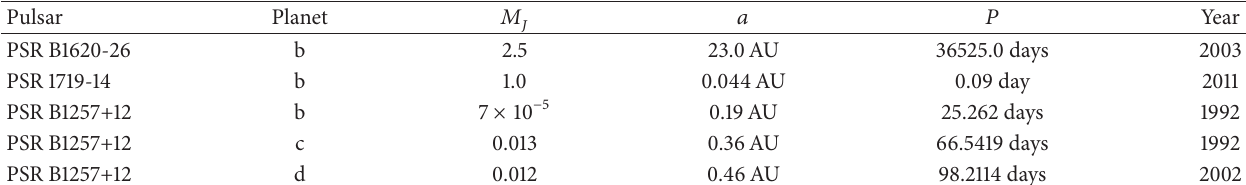
Table 1: Pulsar planets